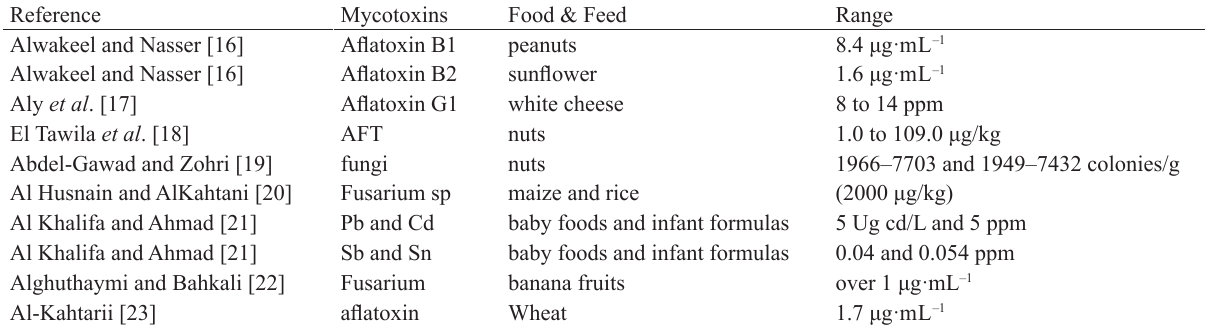
Table 1 Ranges of mycotoxins in food and feed in Saudi Arabia